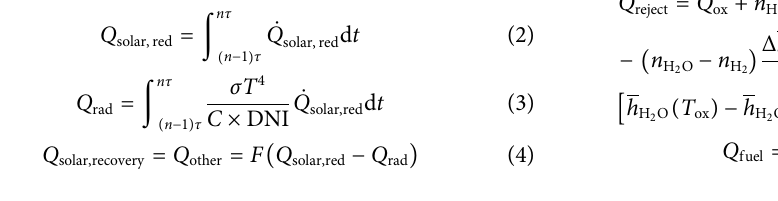
Frontiers in Energy Research |